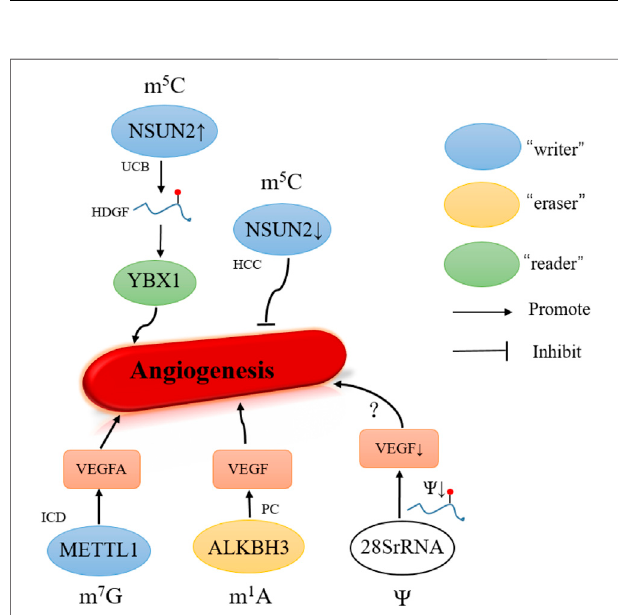
FIGURE 4 | Role of other modi fi cations in angiogenesis. UCB, urothelial carcinoma of the bladder; HCC, hepatocellular carcinoma; ICD, ischemic cardiovascular disease. PC, pancreatic